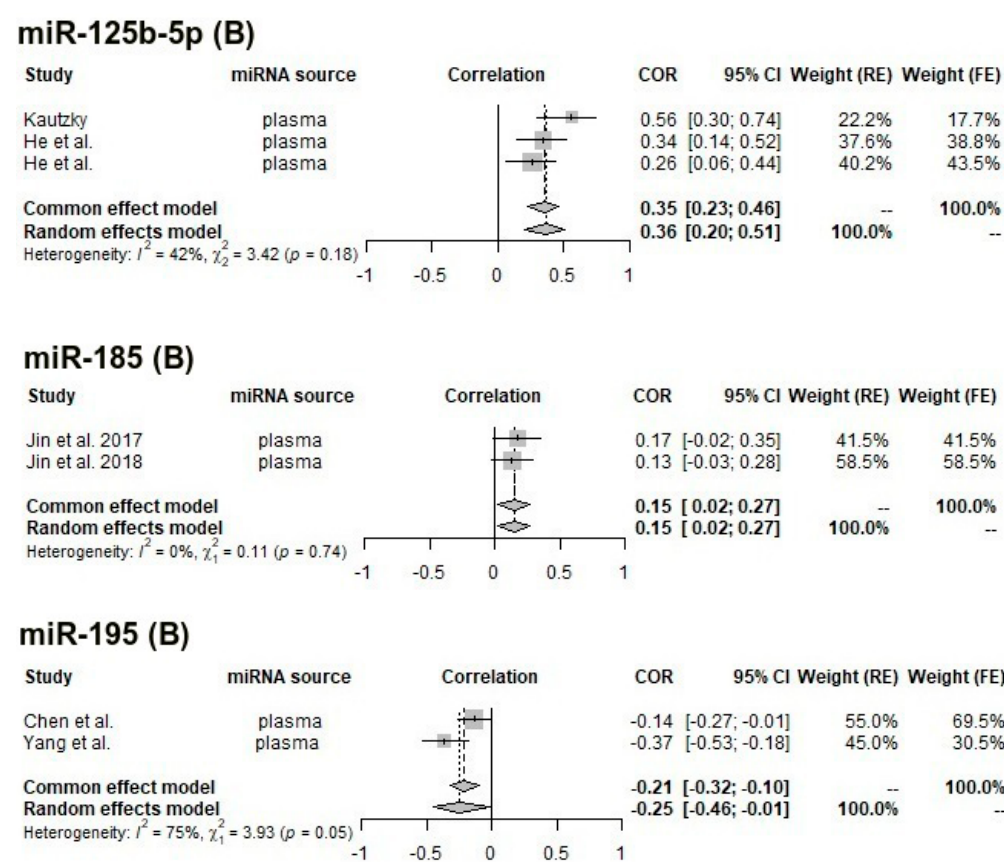
Figure 3. Forest plot for the correlation between the concentration of miR-125a-5p, miR-125b-5p, miR-126, miR-185, miR-195, miR-335, and NIHSS score; in certain cases, we address separately all reported studies ( A ) and ( B ) only studies with reported same miRNA source. References: miR-125a-5p: [40,43]; miR-125b-5p: [43,44,61,62]; miR-126: [64,65]; miR-185: [64,65,87]; miR-195: [51,66,67]; miR-335: [76,78].